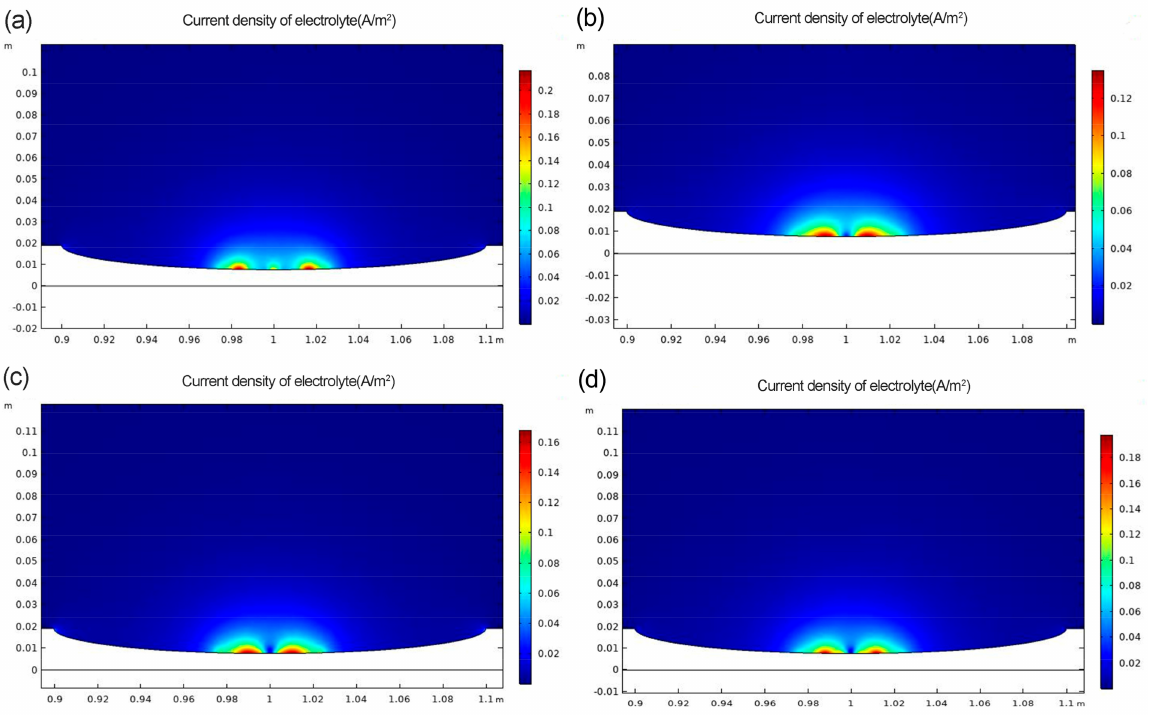
Figure 13. Current density diagram at 3.75 mm tensile displacement ( a ) No. 1 ( b ) No. 2 ( c ) No. 3 ( d ) No. 4.